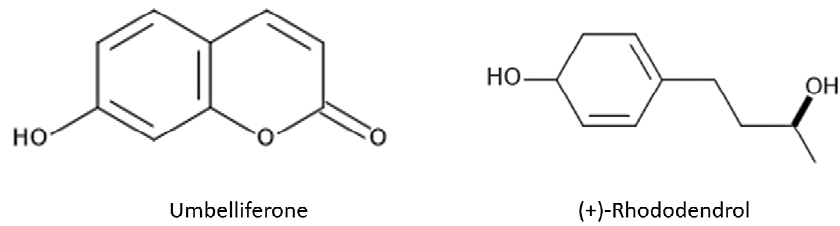
Figure 4. Chemical structures of umbelliferone and (+)-rhododendrol.